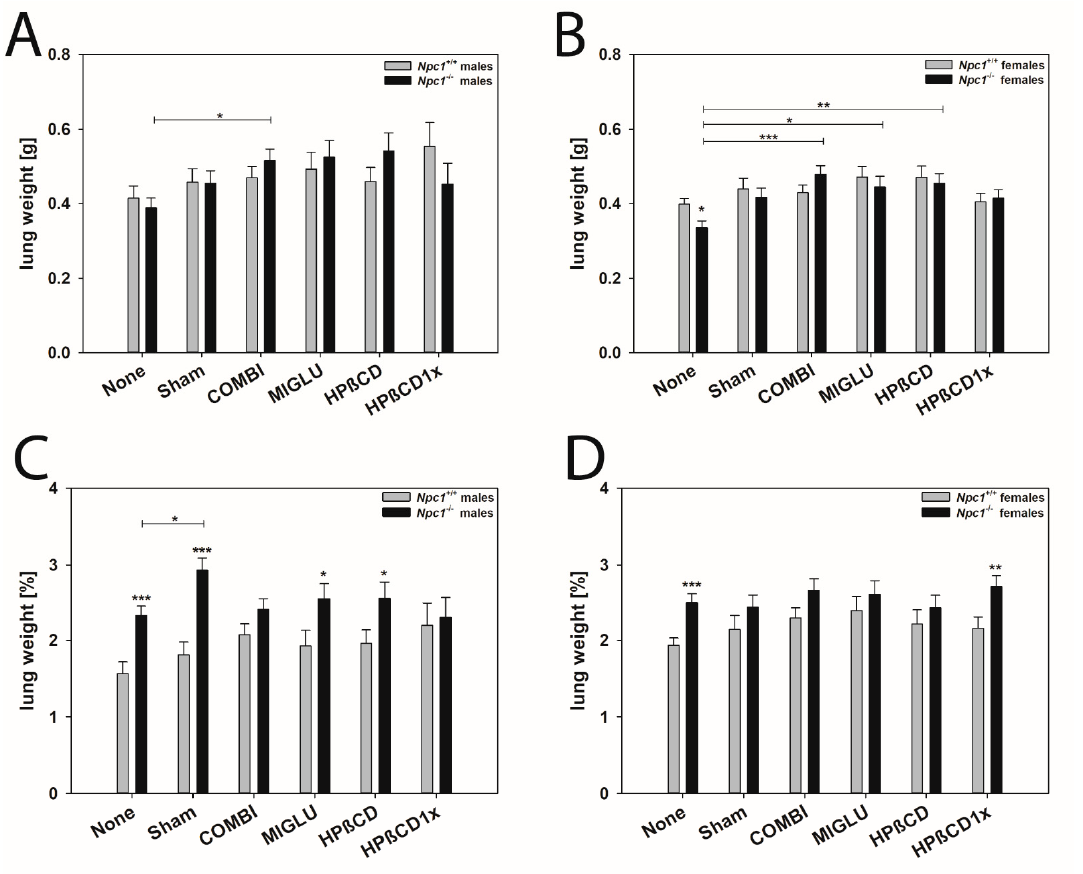
Figure 3. Lung weight ( A , B ) and relative lung weight ( C , D ) of Npc1 mice. Male ( A , C ) and female ( B , D ) mice. Significant post-hoc tests are indicated by asterisks (* p < 0.05, ** p < 0.01, *** p < 0.001). Data are means ± SEM.